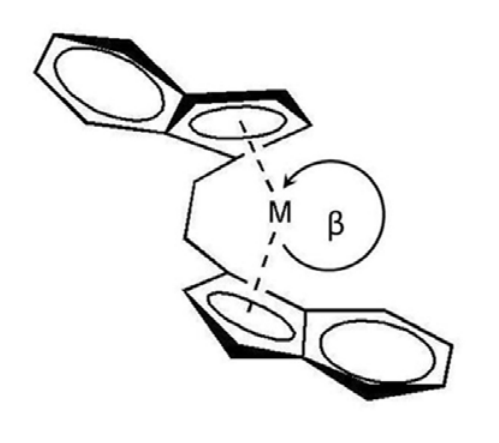
Figure 1. Structure of the opening gap aperture between C metallocene complex, redrawn from the conceptual idea by Braunschweig and Breitling [18].